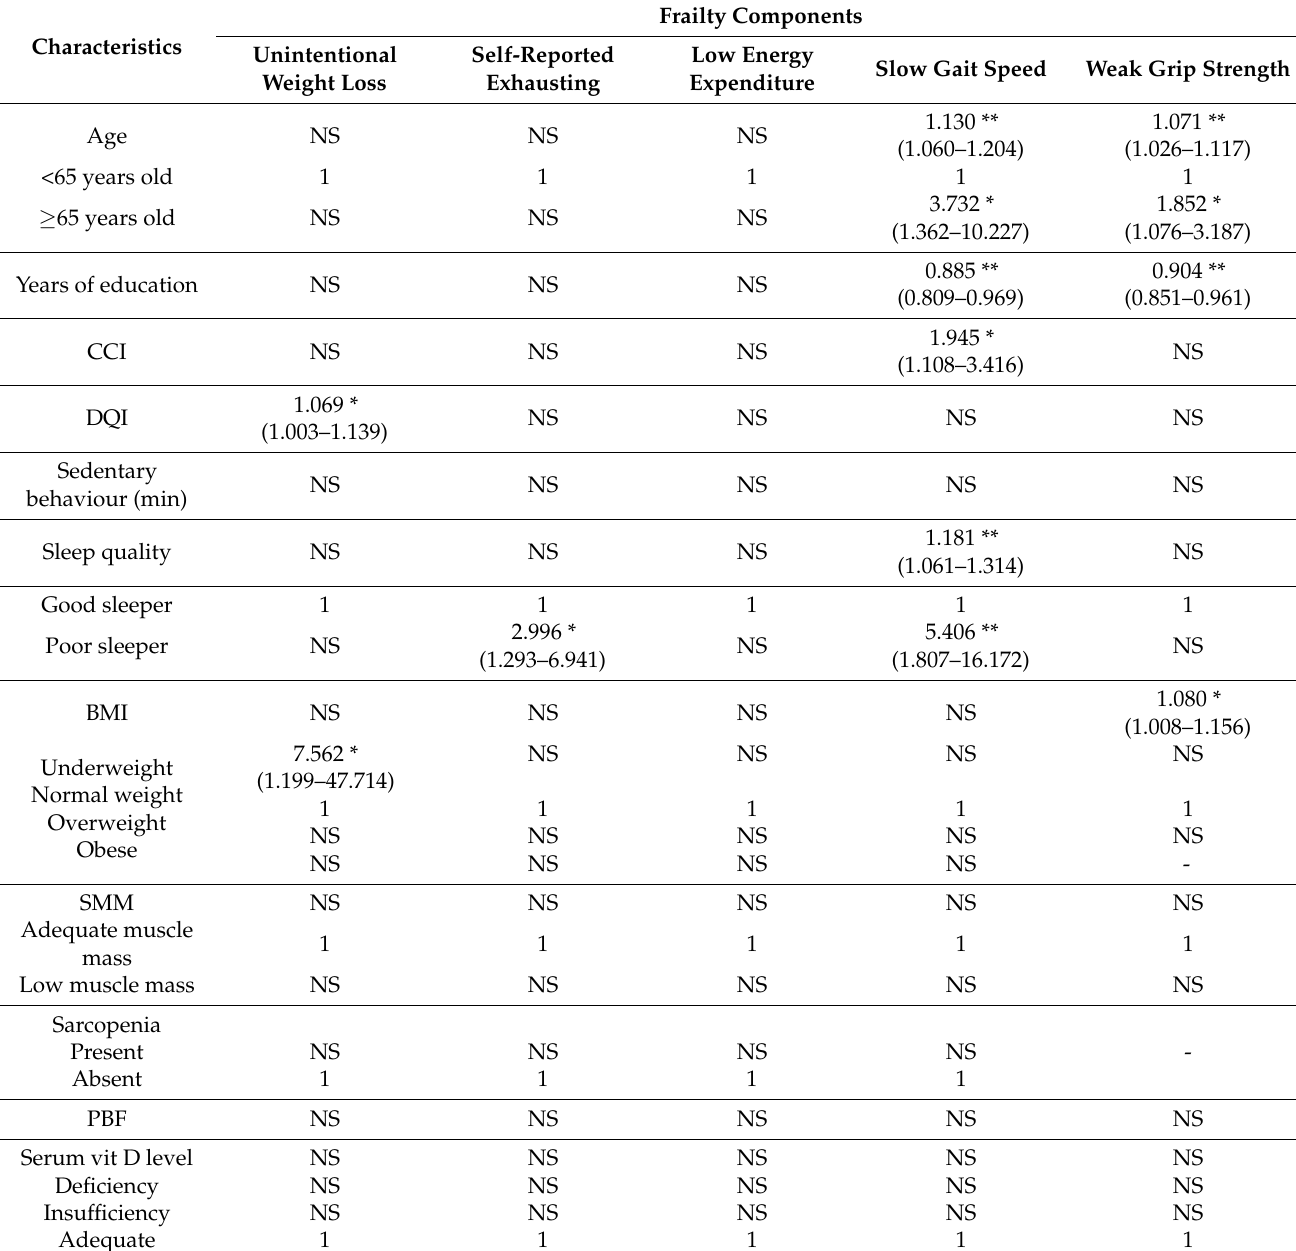
Table 4. Univariate logistic regression between selected variables and components of frailty ( n =